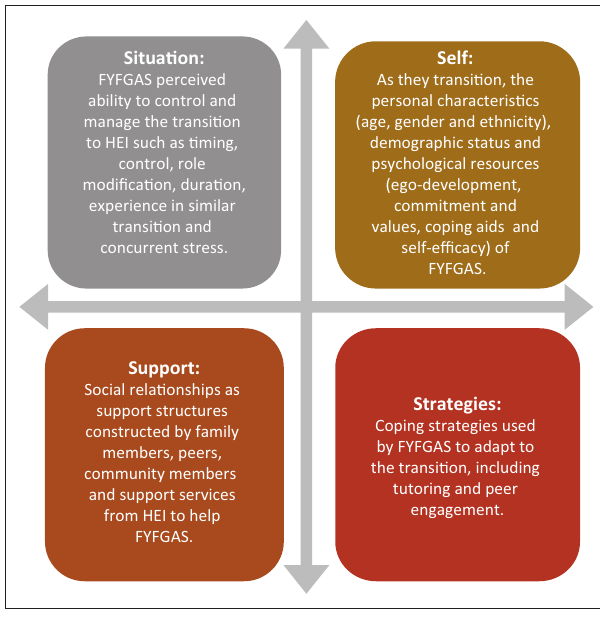
FIGURE 1: Schlossberg’s four ‘S’ factors of transitioning concerning first-year first-generation African students in higher education institutions in South